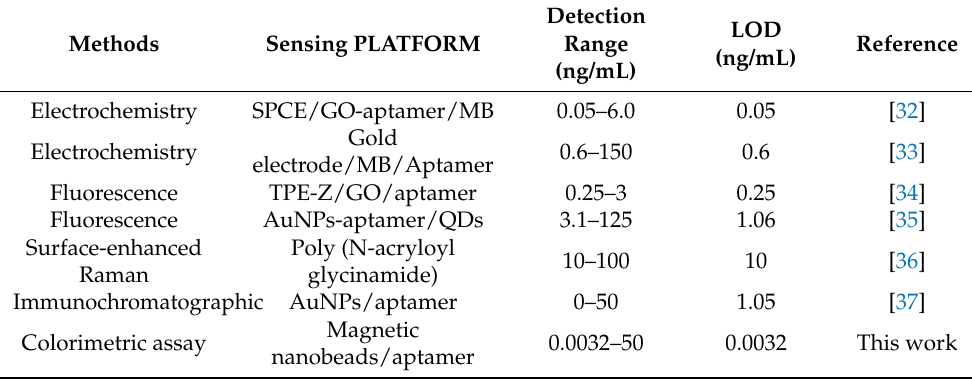
Table 1. Comparison of the developed aptasensor with other different detection methods for AFB1